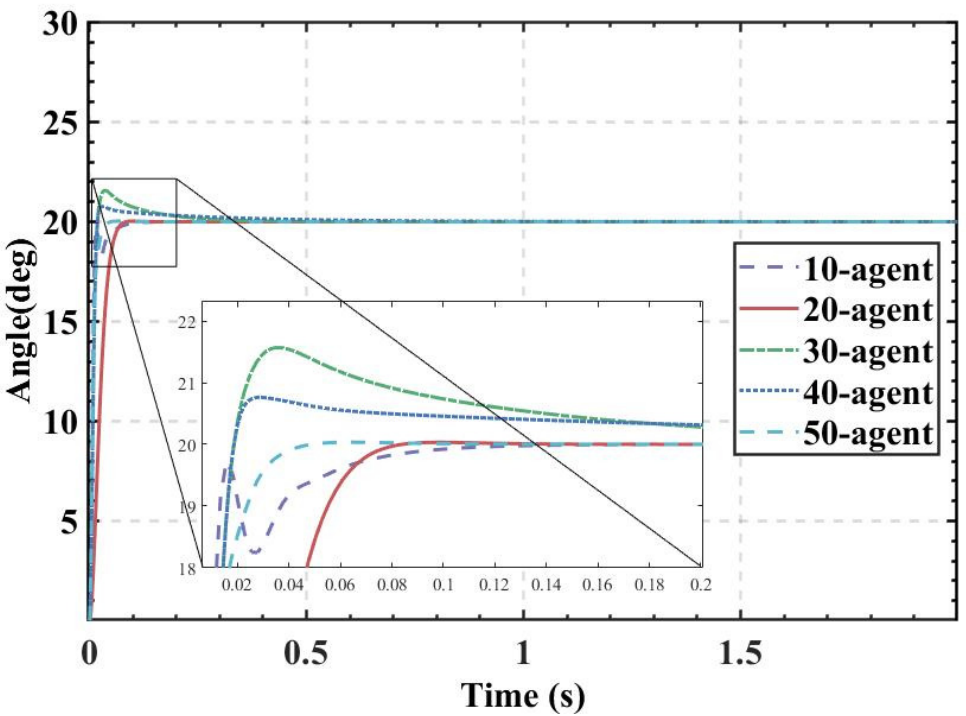
Figure 8. The actual angle of the balancing robot under HBA-PID algorithm.